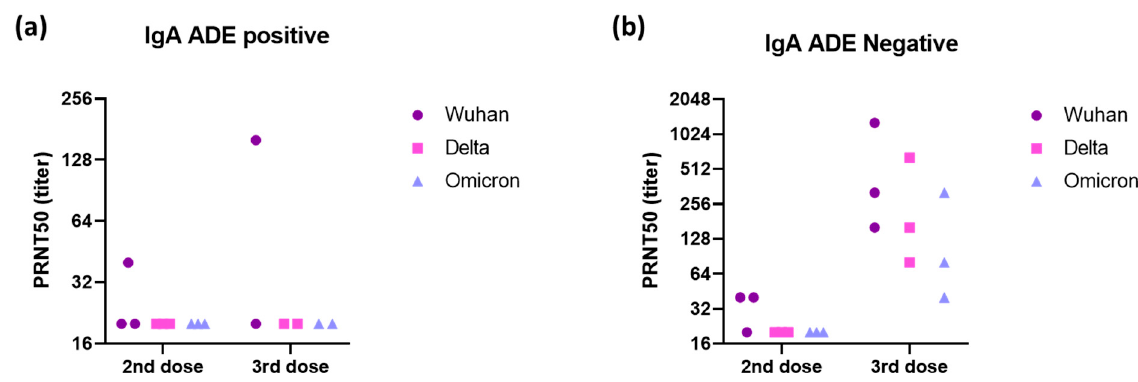
Figure 3. Neutralizing activity of ( a ) three positive and ( b ) three negative sera to IgA-dependent ADE against the Omicron variant (sera dilution starting at 1:20) was evaluated against Wuhan, Delta, and Omicron strains using a plaque reduction neutralization test (PRNT) with VeroE6 cells. Each dot corresponds to one patient.